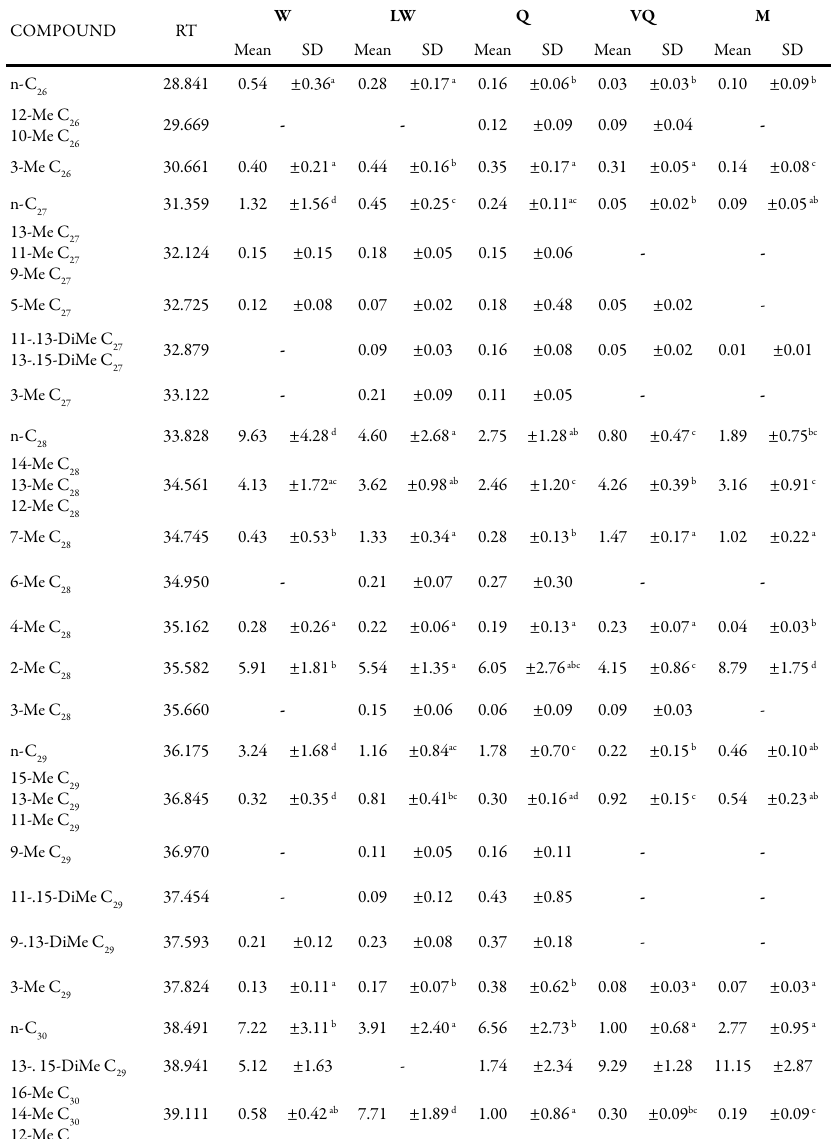
Table 1: Cuticular hydrocarbons present in the Camponotus textor workers (W), major workers (LW), queens (Q), virgin queens (VQ) and males (M). rT = retention time in minutes. different letters indicate significant differences